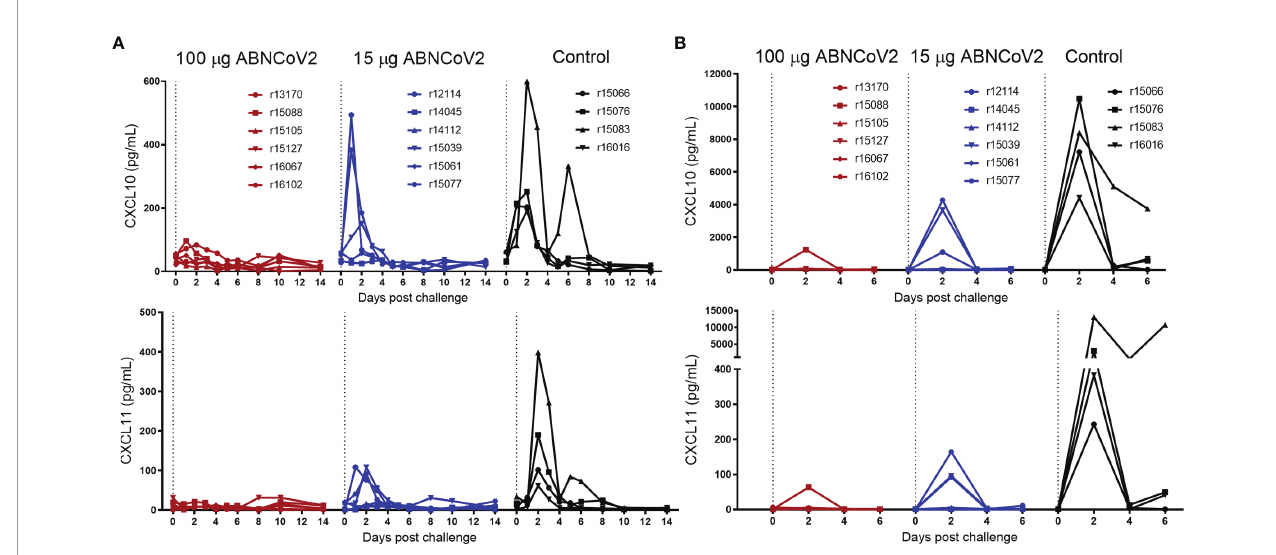
FIGURE 2 | Chemokine changes following SARS-CoV-2 challenge. NHP ( N = 6 per group) were vaccinated intramuscularly with 100 m g ABNCoV2 (red symbols) or 15 m g ABNCoV2 (blue symbols) in weeks 0 and 14 and challenged by the combined intranasal/intratracheal route with SARS-CoV-2 in week 20. As controls, four non-vaccinated rhesus macaques (black symbols) were challenged at the same time. CXCL10 (top graphs) and CXCL11 (bottom graphs) were measured in serum (A) and bronchoalveolar lavage (BAL) (B) on the days post-challenge as indicated. Each curve represents an individual animal. The symbol shapes identify individual animals as stated and the same symbols are used for the same animals throughout all post-challenge